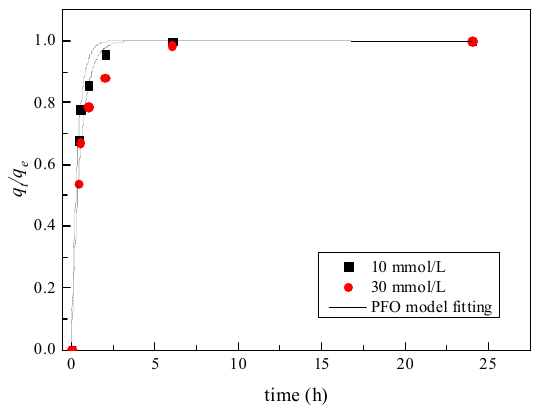
Figure 6. Pseudo first order model.